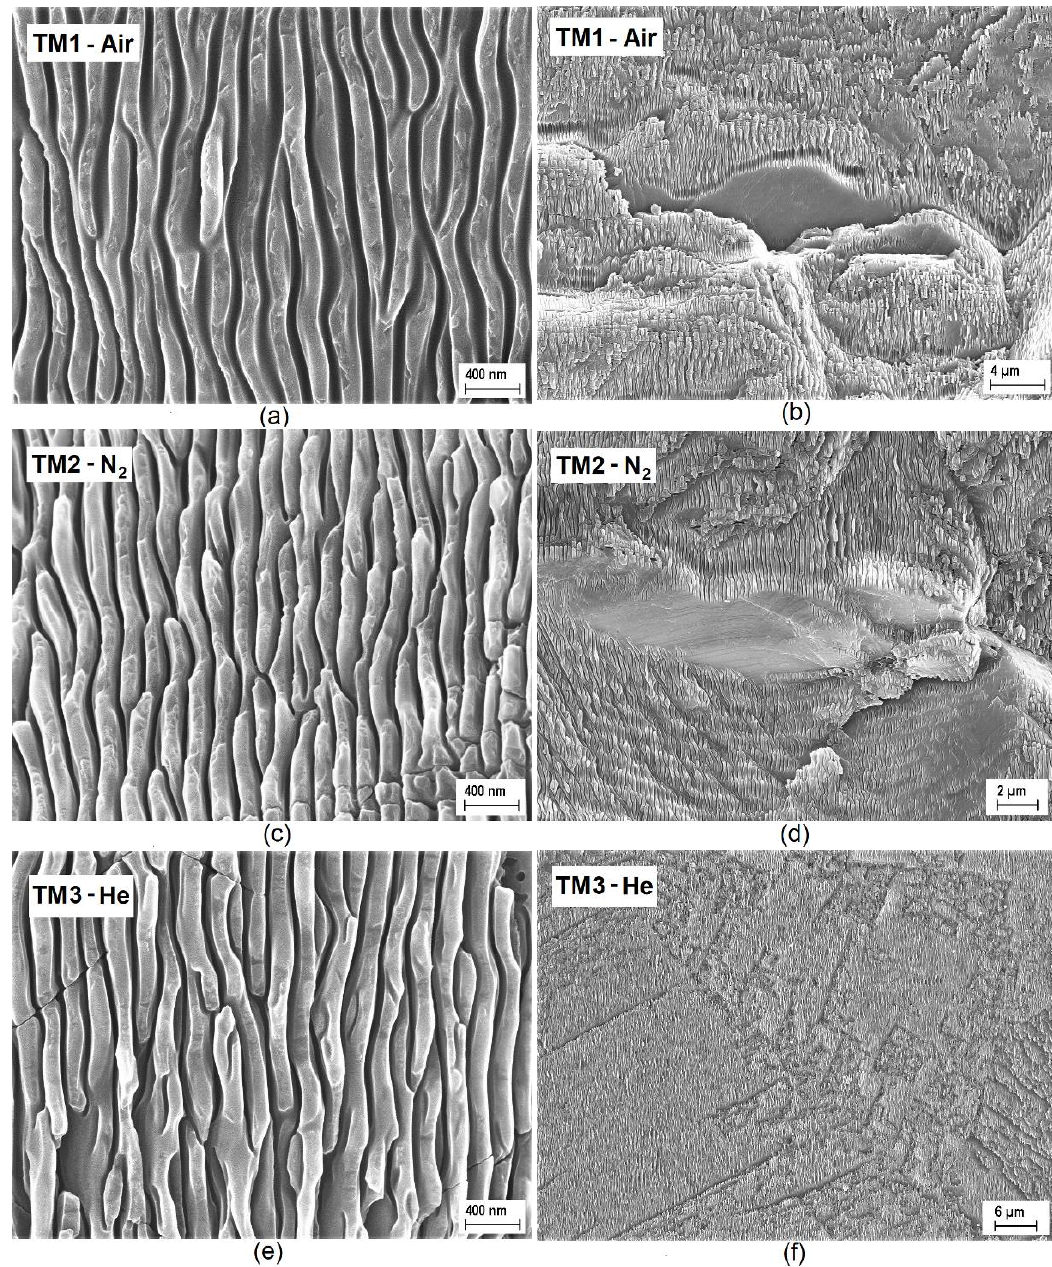
Figure 2. Higher magnification (left) and lower magnification (right) SEM images of the surface of samples TM1, TM2, and TM3, laser-treated under a compressed air ( a , b ), a N 2 ( c , d ) and a He ( e , f ) flow, respectively.